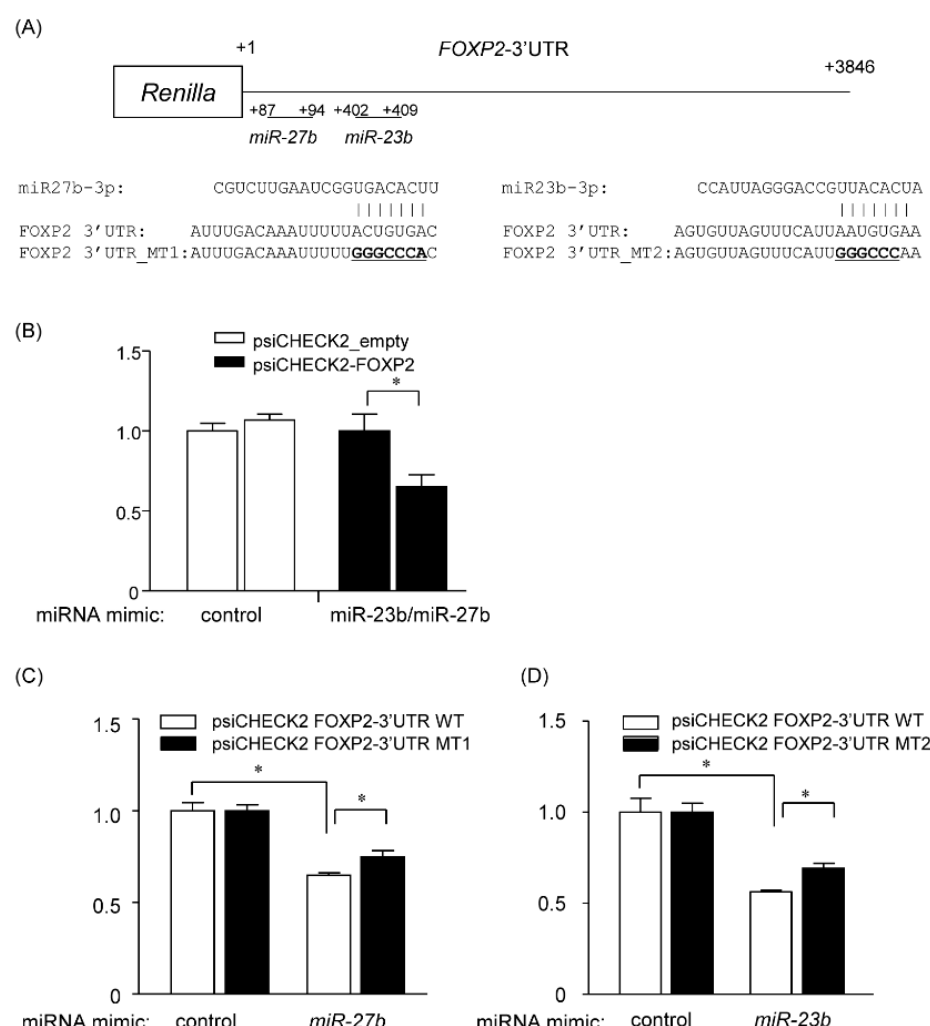
Figure 7. FOXP2 is directly targeted by both miR-23b and miR-27b . ( A ) miRDB predicted a putative binding site of miR-23b (nt 402–409) and of miR-27b (nt 87–94) in the FOXP2 3’ UTR region. The mutated (MT) sequences of the putative binding sites are shown as FOXP2 3’UTR_MT1 or MT2. ( B ) psiCHECK2 vector containing the full length of 3’ UTR in FOXP2 or empty vector was co-transfected with both miR-23b and miR-27b . Renilla luciferase activity was normalized to firefly luciferase. Fold-change values were normalized to empty vector. ( C , D ) psiCHECK2 vector containing the full length of 3’ UTR in FOXP2 (psiCHECK2 FOXP2-3’UTR WT) or the mutated binding sequences (psiCHECK2 FOXP2-3’UTR MT1 or MT2) were co-transfected with either mimic miR-23b or miR-27b . Renilla luciferase activity was normalized to firefly luciferase. Fold-change values were normalized to empty vector. Fold-change values were then normalized to mimic control-treated cells. Data are expressed as the mean ± standard deviation (SD; n = 4). * Statistically significant difference versus control ( B – D ) or WT ( C , D ) (unpaired Student’s t -test, p < 0.05).